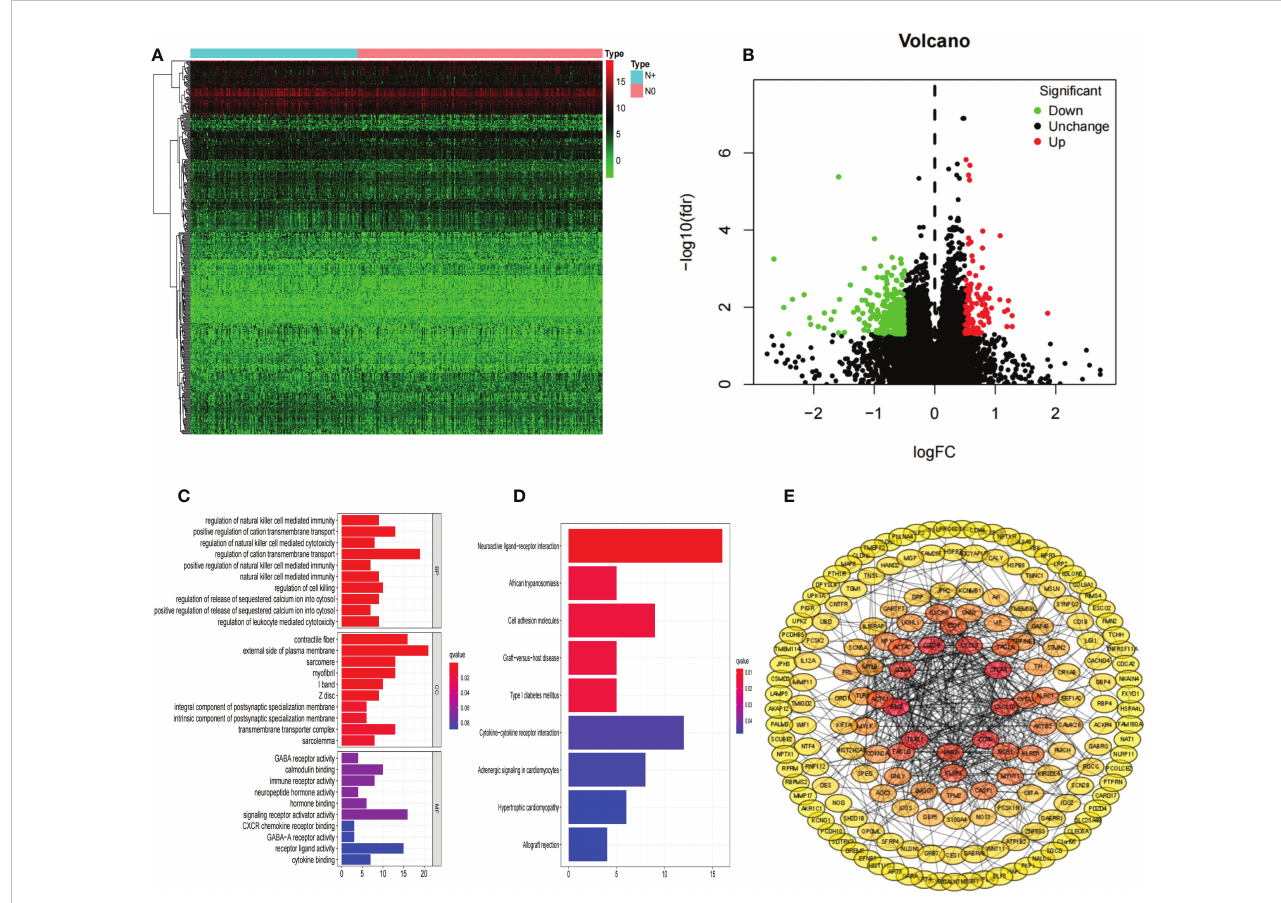
FIGURE 2 DEGs. Hierarchical clustering analysis of genes (A) ; Volcano plots were constructed using fold-change values and adjusted P (B) ; Red dots represent upregulated genes, and green dots represent downregulated genes. The GO analyses (C) ; KEGG pathway analyses (D) ; PPI network of differentially expressed genes (E) . DEGs, differentially expressed genes; COAD, colon